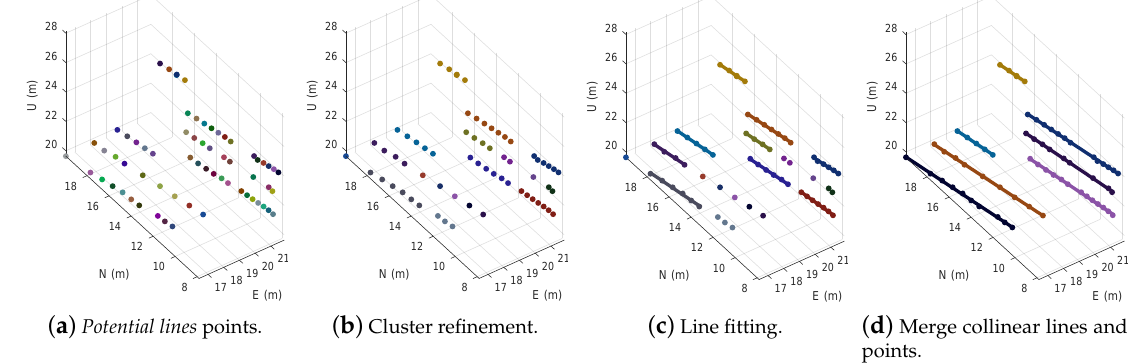
Figure 8. Line detection